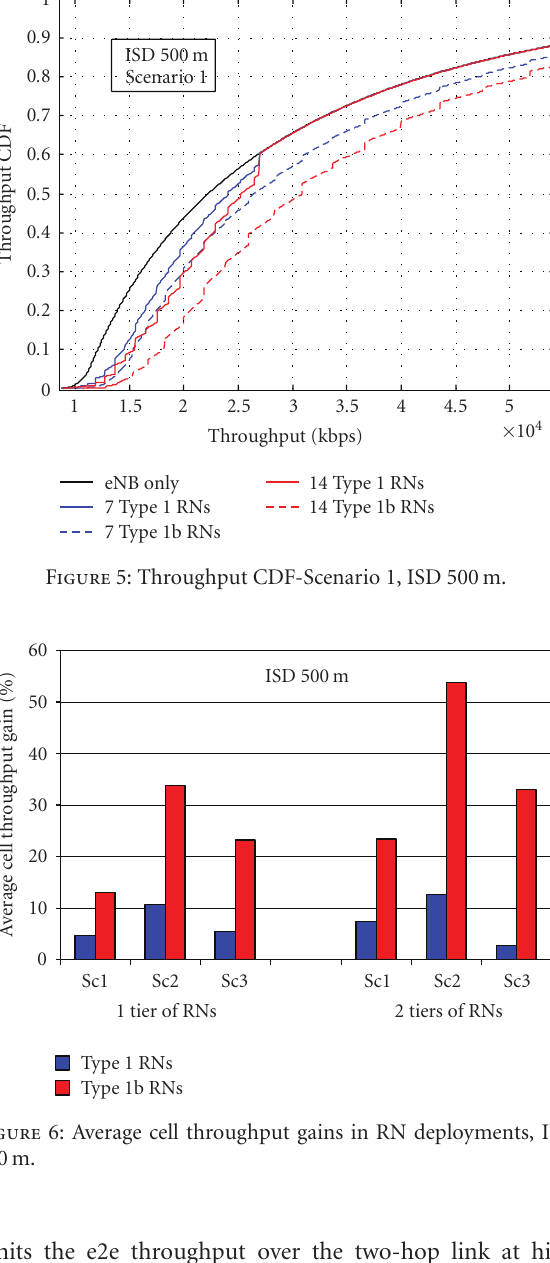
Table 6: Coverage extension evaluation, ISD 1732 m.